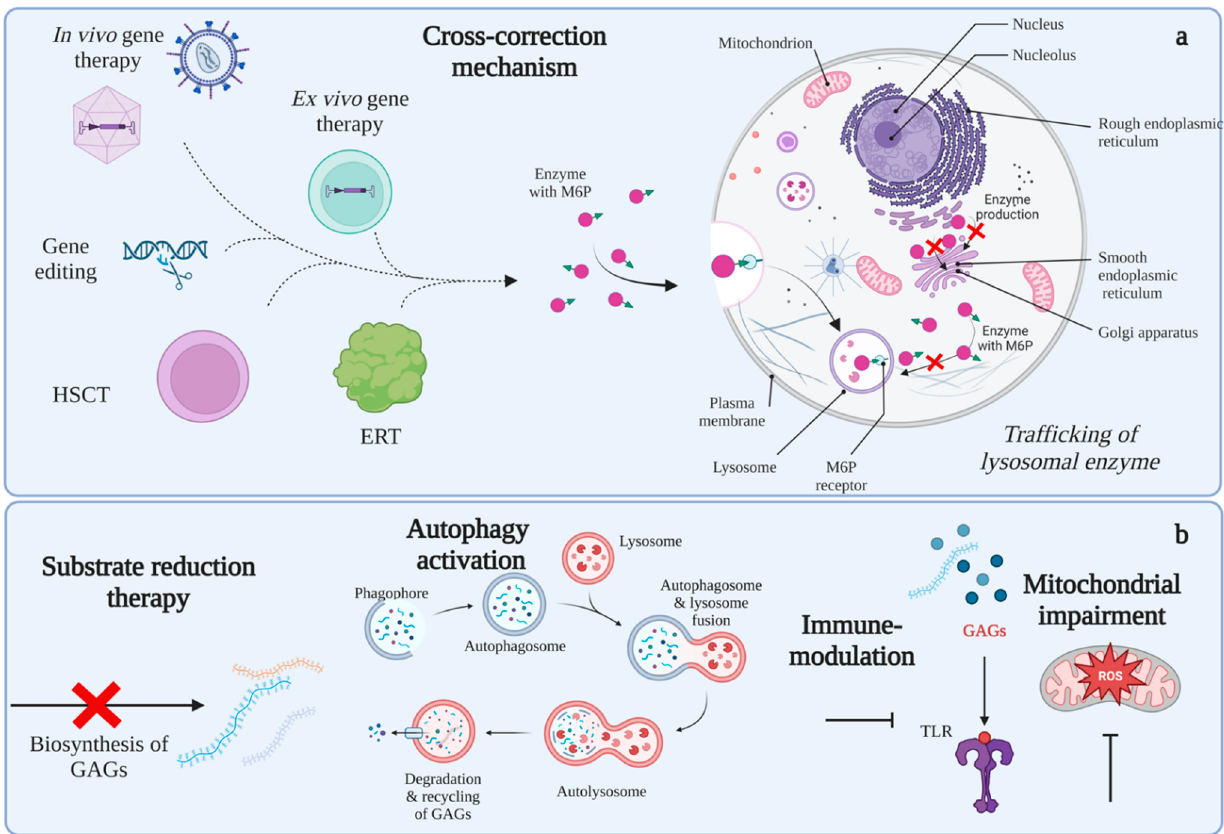
Figure 3. Potential therapies for MPS. Panel ( a ) shows possible treatments based on the cross-correction mechanism, including gene therapy, ERT, and HSCT. Panel ( b ) shows potential therapies not based on cross-correction mechanisms, such as substrate reduction therapy, autophagy activation, immune modulation, and mitochondrial impairment. Note that every organelle affected in MPS can be susceptible to intervention to recover cell homeostasis, together with current strategies to supply missing enzymes. This figure was created with BioRender.com.